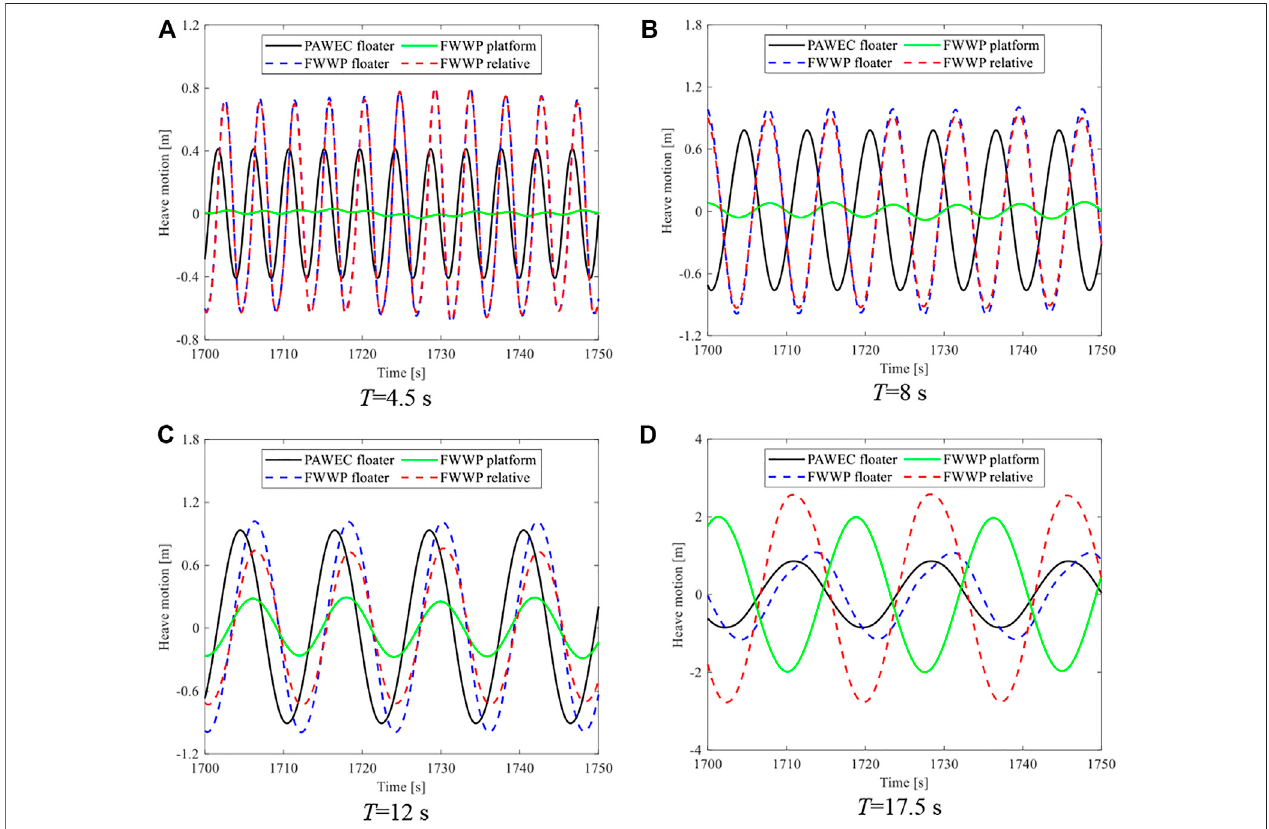
FIGURE 15 | Heave motion of the fl oater in the PAWEC, compared with the fl oater and platform and their relative motion in the FWWP under regular wave. (A) T =4.5 s. (B) T =8 s. (C) T =12 s. (D) T =17.5 s.